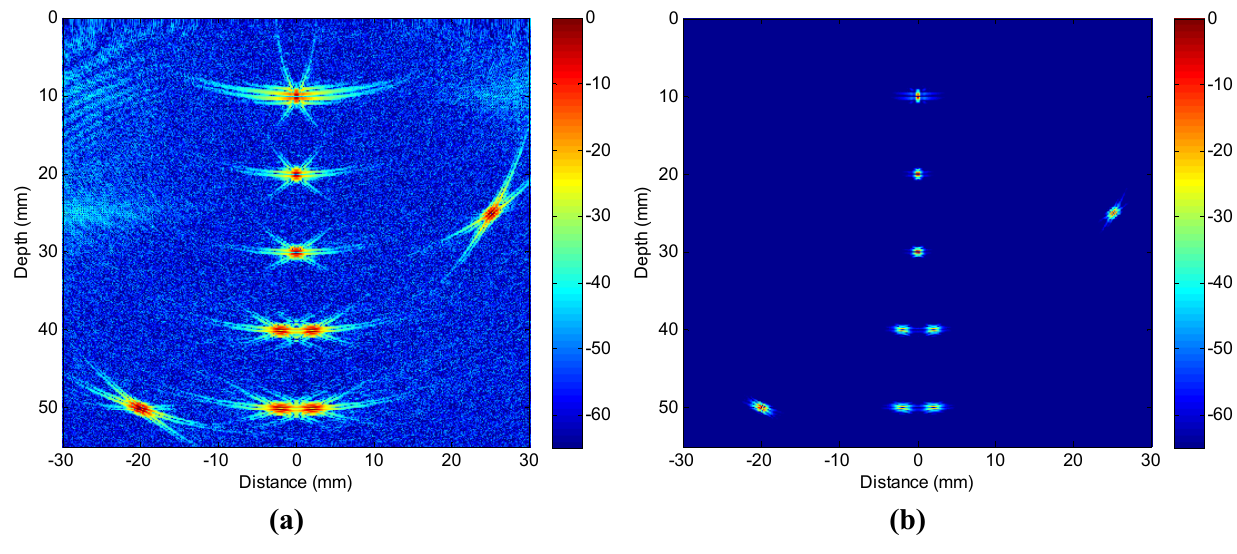
Figure 6. Simulated images with a 65 dB dynamic range obtained with (a) total focusing method, and (b) adaptive beamforming. Array is dynamically focused at every point in image on both transmission and